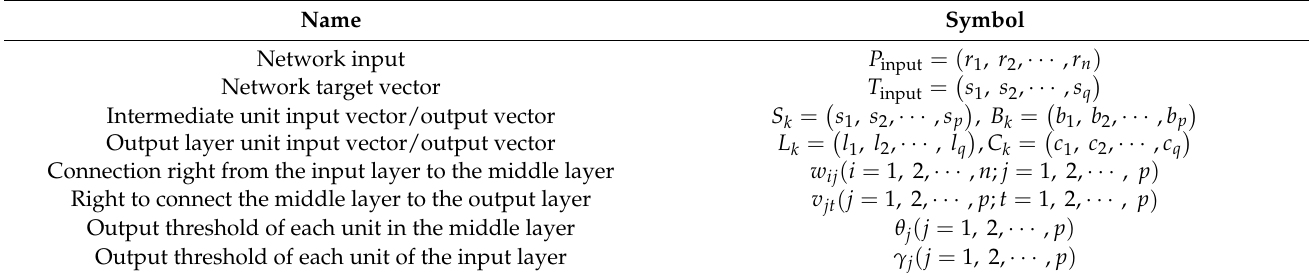
Table 2. Meanings of symbols in the BP Network Training